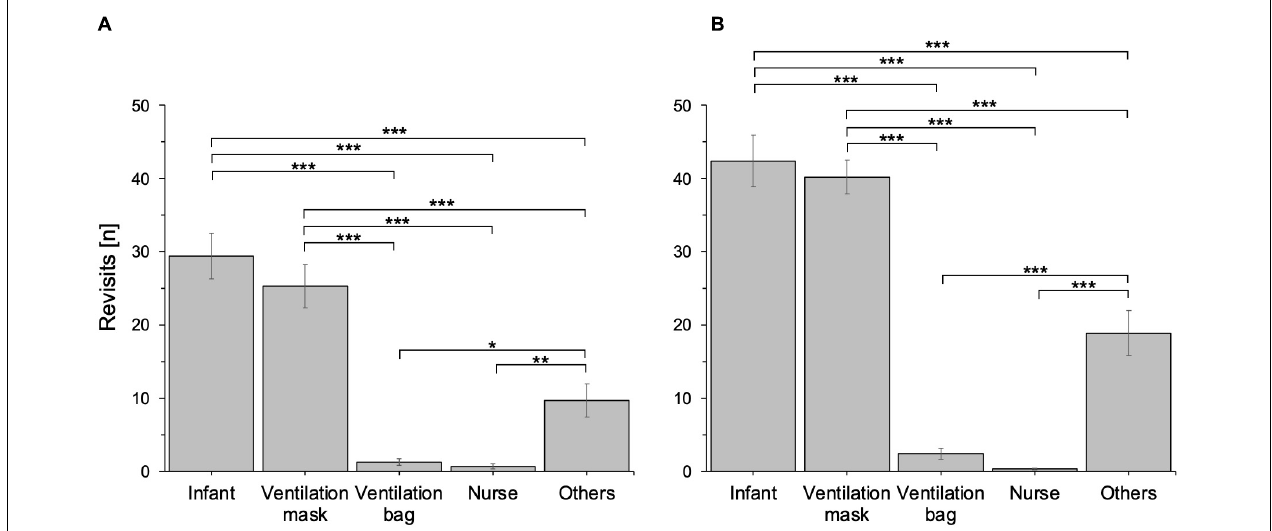
FIGURE 2 | Mean number of revisits to the study AOIs during the chest compression scenario (A) and the ventilation scenario (B) . Error bars are standard errors of the mean (SEM). N = 40, * p < 0.05, ** p < 0.01, *** p < 0.001. TABLE 2 | Correlations of revisits and transition count with chest compression and ventilation parameters. Revisits Transitions Infant Ventilation mask Ventilation bag Nurse